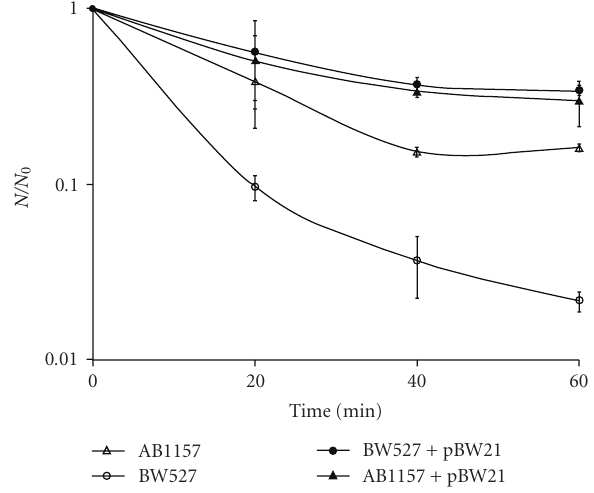
Figure 3: Survival fraction of E. coli AB1157, AB1157+pBW21, BW527, and BW527 + pBW21 treated with SnCl 2 . Mid-log phase cells suspended in 0.9% NaCl were treated with 25 μ g/mL SnCl 2 for di ff erent incubation times and the specific survival fraction. Survival fraction values are means ± standard deviations of the three isolated experiments.